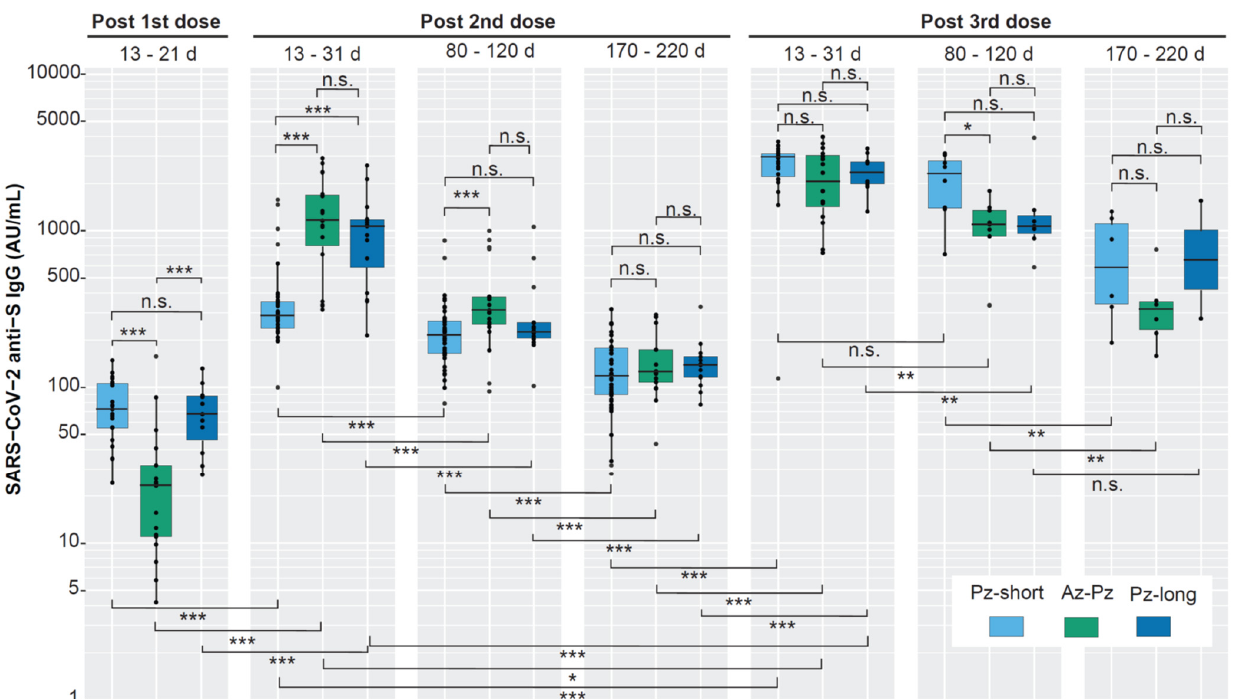
Figure 3. Anti-S IgG levels (AU/mL) elicited by the first, second, and third vaccine dose in the three vaccine groups and anti-S IgG persistence up to 21 months post initial vaccination. For the 1st dose, only one time period (13–21 days post-vaccination) was included. For the second and third doses, two additional time periods (80–120 days and 170–220 days post vaccination) were included. The box denotes the interquartile range (IQR), the horizontal line inside the box denotes median. The vertical whiskers that extend from the box indicate 1.5 × IQR. The Wilcoxon rank sum test was used to compare median antibody levels between groups at every time interval (shown above the boxes), and over time within the same group (shown below the boxes, Table 2). A Kruskal–Wallis test was also used to check if at least one of the three vaccine groups were significantly different from the others at the same time interval (Table S1). P -value < 0.05 is noted *, p < 0.01 **, and p < 0.001 ***, and non-significant (n.s.). Table 2. SARS-CoV-2 anti-S IgG concentration (AU/mL) post-vaccination.